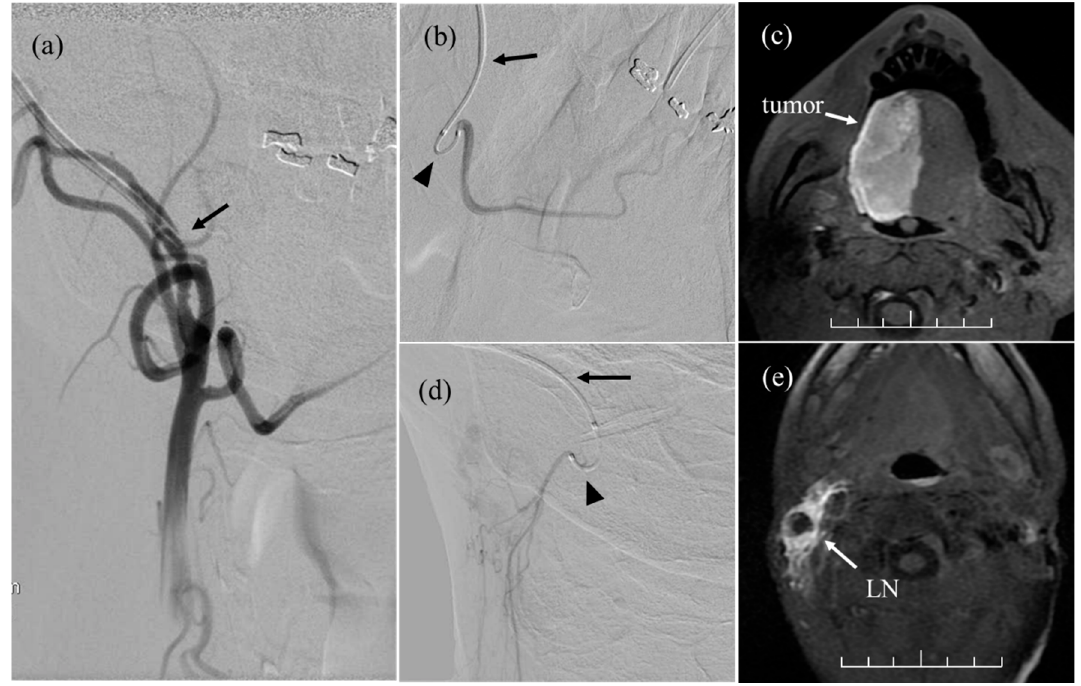
Figure 2. ( a ) External carotid arteriography obtained by administering contrast media via the external carotid arterial sheath (ECAS) on digital subtraction angiography (DSA). Arrow: tip of ECAS. ( b ) Superselective lingual arteriography via a steerable microcatheter through the ECAS on the DSA. Arrow: tip of ECAS; arrowhead: a steerable microcatheter. ( c ) Magnetic resonance image showing the injected contrast agent via the right lingual artery. ( d ) Arteriography of a branch from the ECA to the metastatic lymph nodes on the DSA. ( e ) Magnetic resonance image showing the injected contrast agent via the direct branch from the ECA. Scale